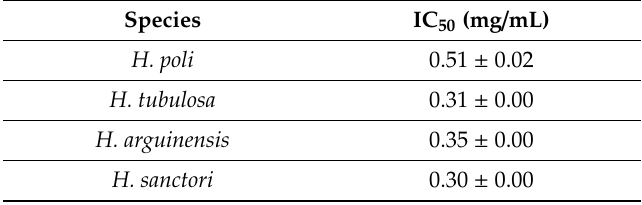
Table 7. IC 50 values obtained from the studied sea cucumbers hydrolysates (Alcalase 5%, < 1